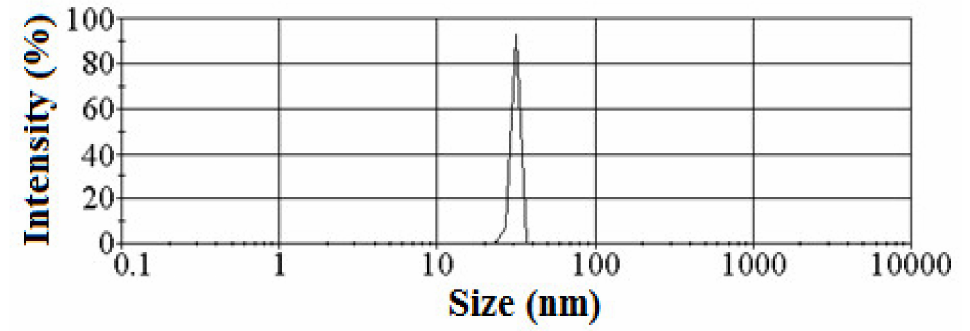
Figure 1. A-SiO 2 particle size distribution with an average size of 30